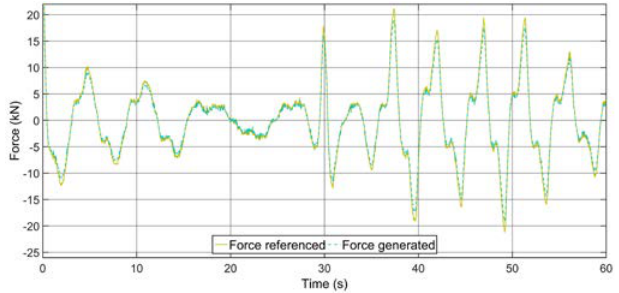
Fig. 14. Referenced and generated force for Case II, 0-29 s, and Case III, 30-60 s in the proposed control.